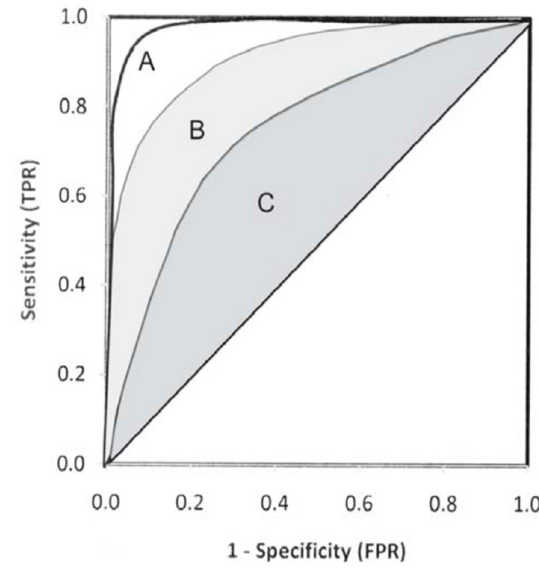
Figure 13. The comparation between the different Area Under ROC Curve (AUC) curve.